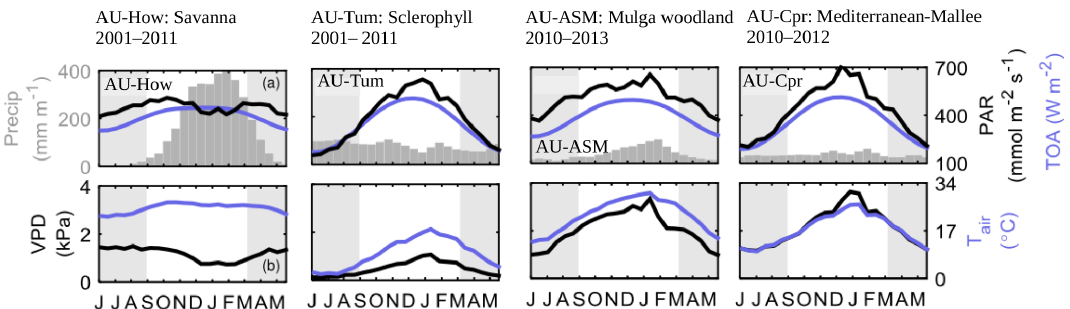
Figure 3. Savanna (AU-How), wet sclerophyll (AU-Tum), mulga (AU-ASM), and mallee (AU-Cpr) ecosystems, OzFlux sites annual cycle (16-day composites) of (a) precipitation (Precip; mmmonth − 1 ) (grey bars) and photosynthetic active radiation (PAR; µmolm − 2 d − 1 ) (blue line), and (b) vapour pressure deficit (VPD; kPa) (black line) and air temperature ( T air ; ◦ C) (blue line). Grey boxes indicate Southern Hemisphere spring and summer September to